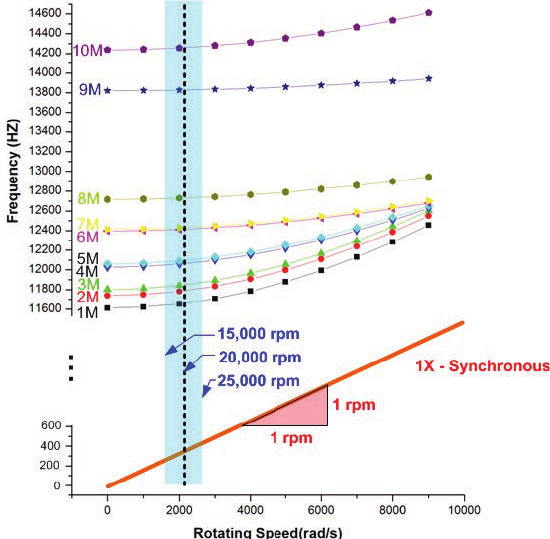
Fig.14. Campbell diagram of 8B impeller Figure 14. Campbell diagram of 8B